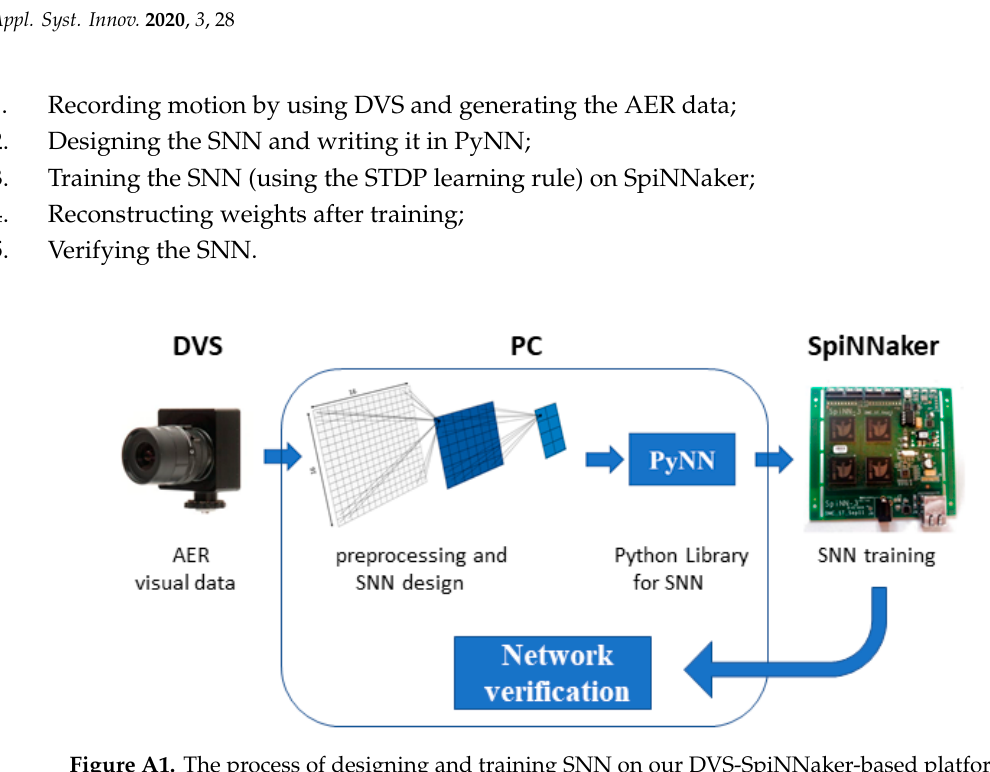
Figure A1. The process of designing and training SNN on our DVS-SpiNNaker-based platform.